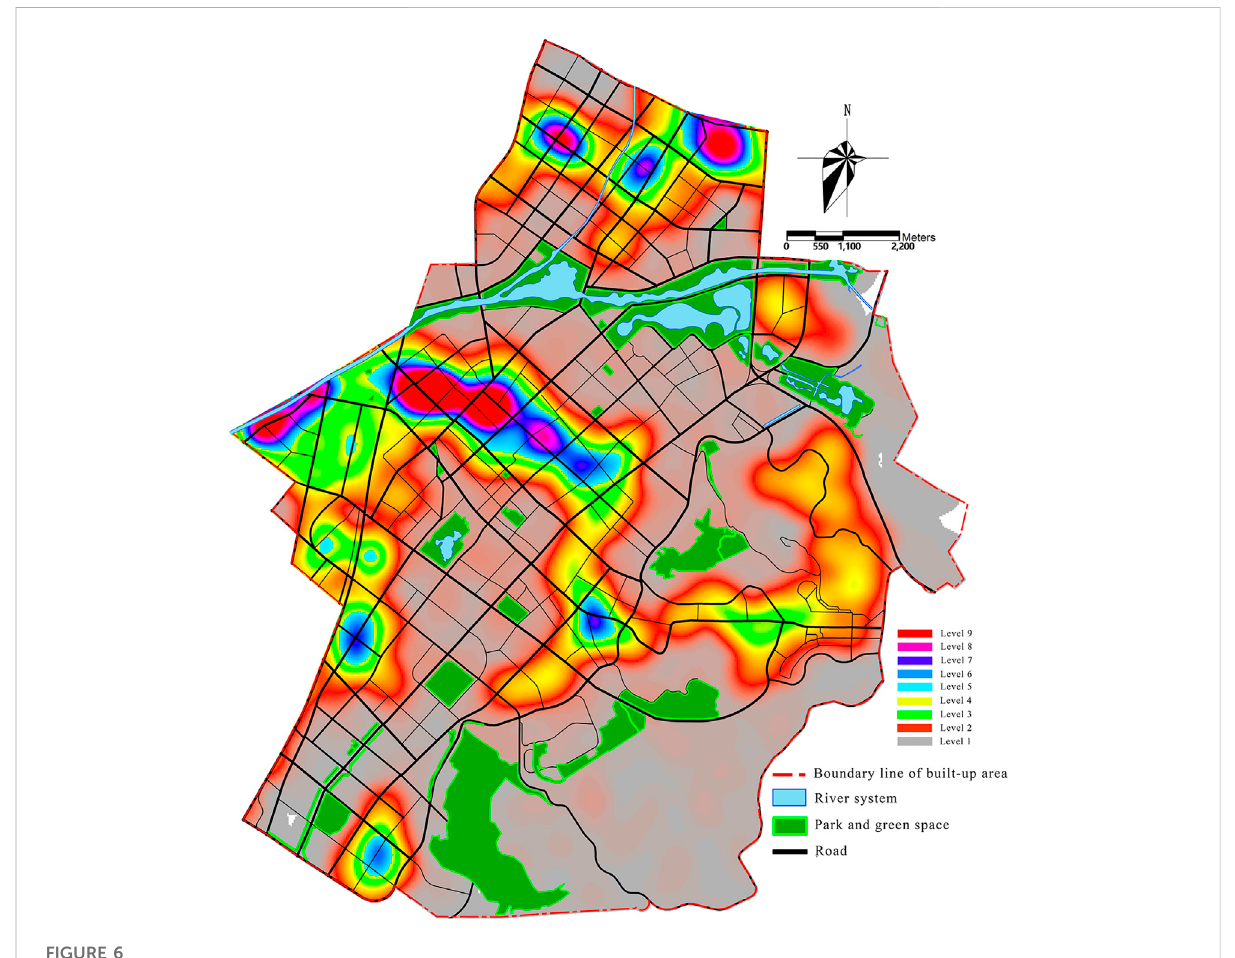
FIGURE 6 Spatial distribution of demand on urban green spaces in Yuxi City Center.